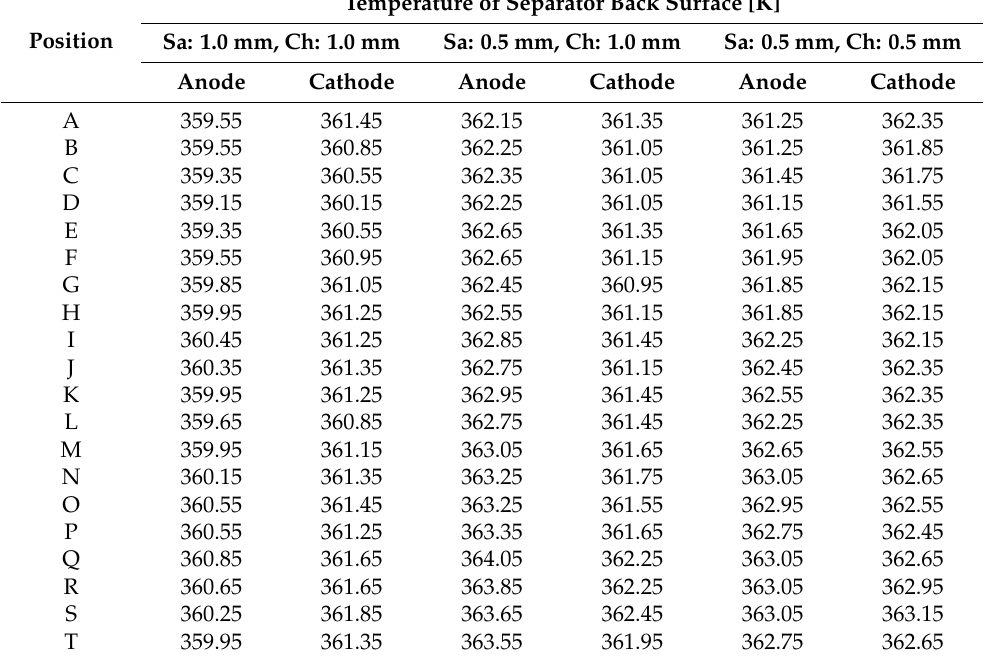
Table 4. Comparison of temperature of separator back surface among different s.t. at 363 K for A40%RH, C40%RH